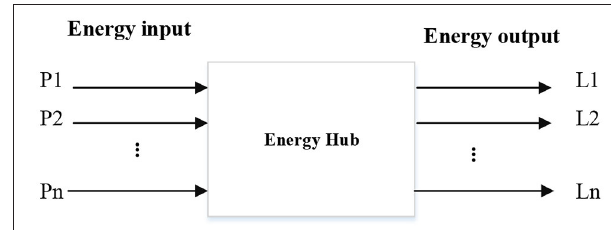
FIGURE 3 | Model of